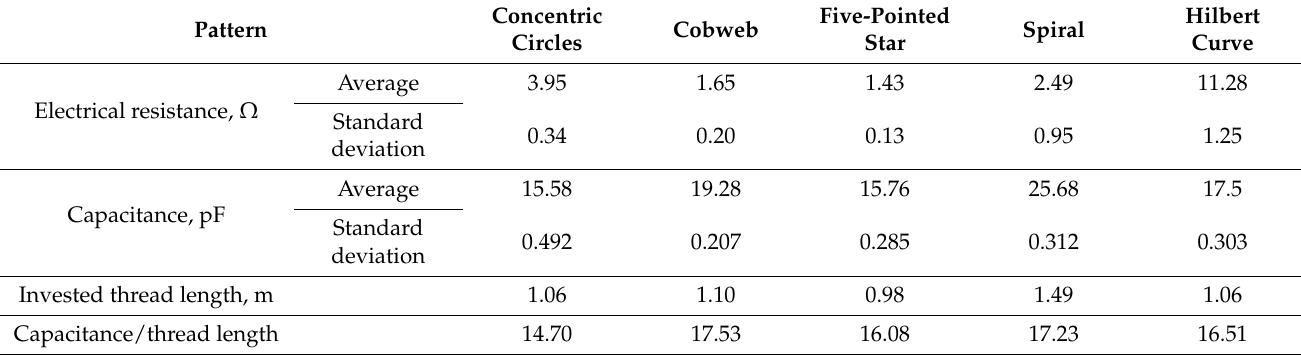
Table 1. Electrical resistance and capacitance of the sensors in different embroidery